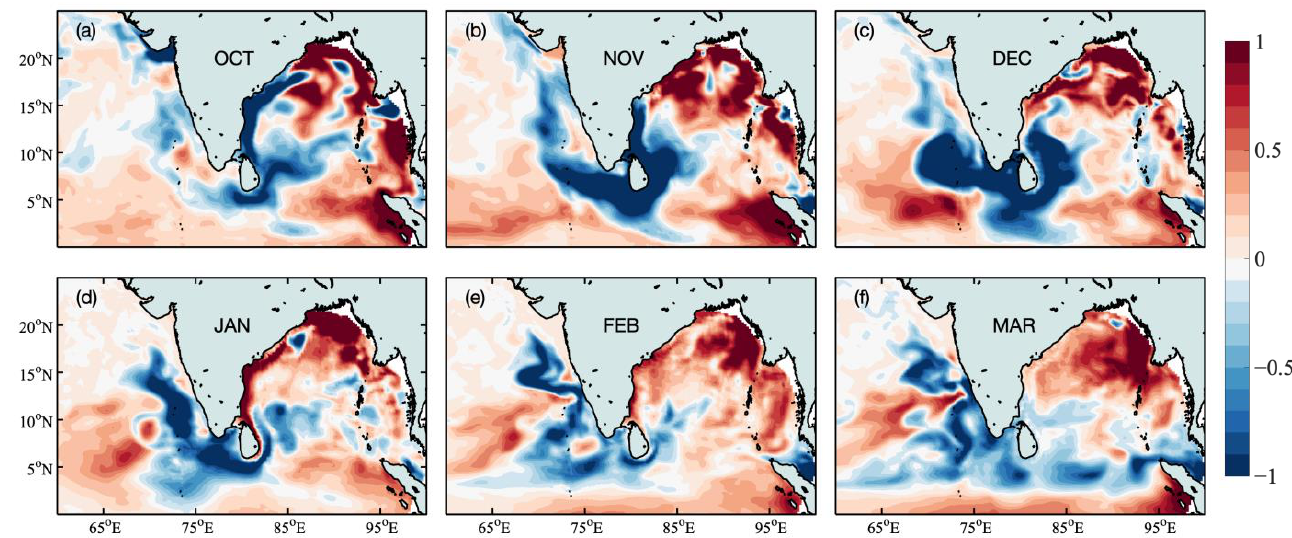
Figure 13. Monthly distribution of anomalies of salinity difference between surface and 50 m depth (shaded; psu) in ( a ) October 2010, ( b ) November 2010, ( c ) December 2010, ( d ) January 2011, ( e ) February 2011, and ( f ) March 2011 based on ORAS5 data.